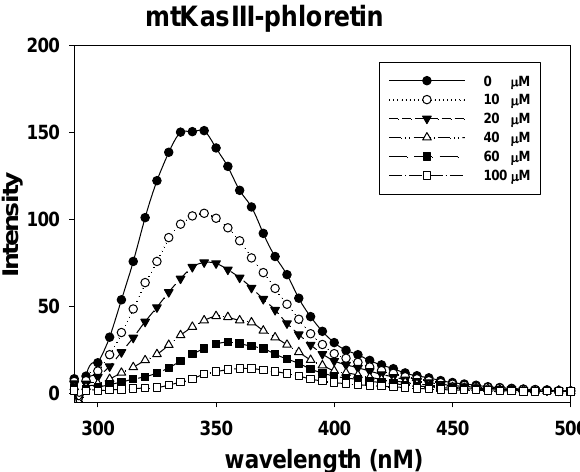
Figure 8. Fluorescence spectra of mtKASIII in the presence of 0, 10, 20, 40, 60, and 100 μM phloretin at pH 7.0. Samples were excited at 290 nm, and emission spectra were recorded at 290–600 nm.